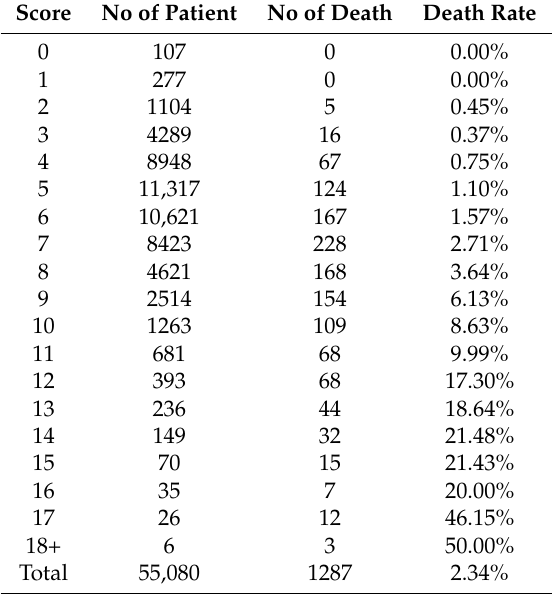
Table 5. Mortality (%) by different cumulative comorbidity scores among locoregionally advanced head and neck squamous cell carcinoma patients receiving curative surgery.